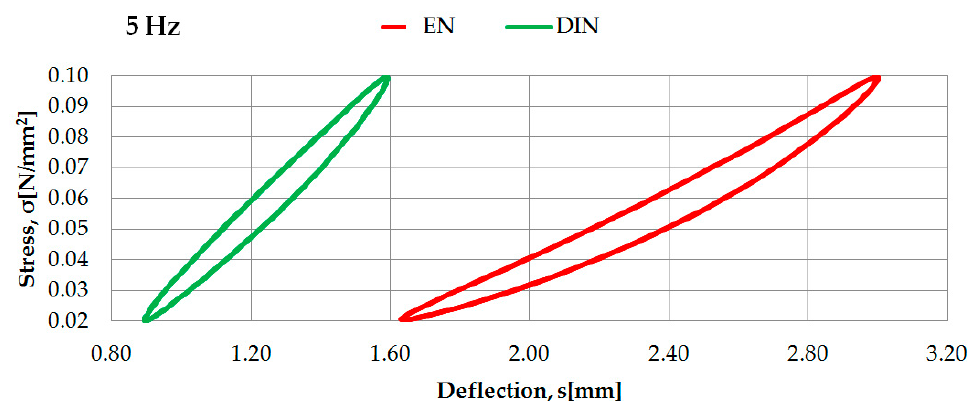
Figure 6. Dynamic characteristics in low frequencies of UBM 045 determined according to DIN [23] and EN [24].